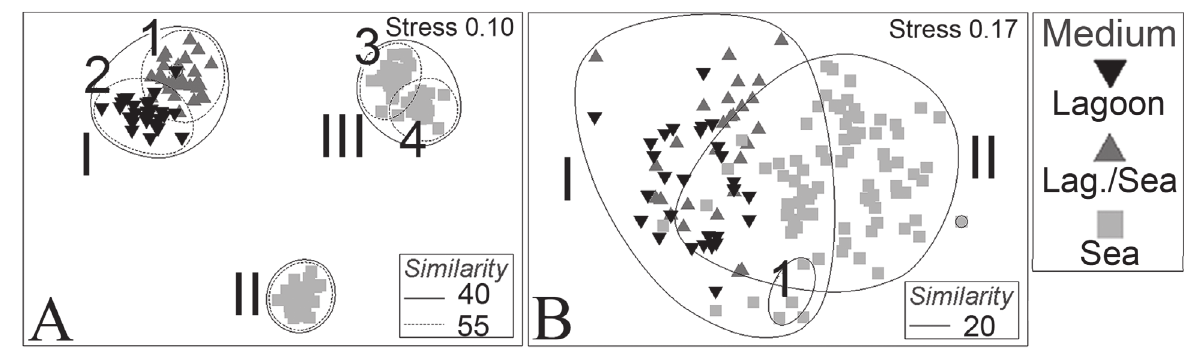
Fig . 4. – multivariate ordinations with overlying clusters of sites in accordance with Bray-curtis species similarity of individual communities of Pinna nobilis . A . Sessile epifauna on 150 sampled shells. B . motile epifauna on 144 samples (six outliers excluded). two opposite patterns are displayed, with sessile assemblage best discriminating samples in terms of geographic location/habitat type (clusters i, ii, iii) and, second- arily, in terms of sampling site (from cluster 1 to 4). motile assemblage is more ubiquitous among Pinna shells and is roughly discriminated by the large geographical scale (cluster i and ii, plus sub-cluster 1 and one sample apart. “Lag.”,